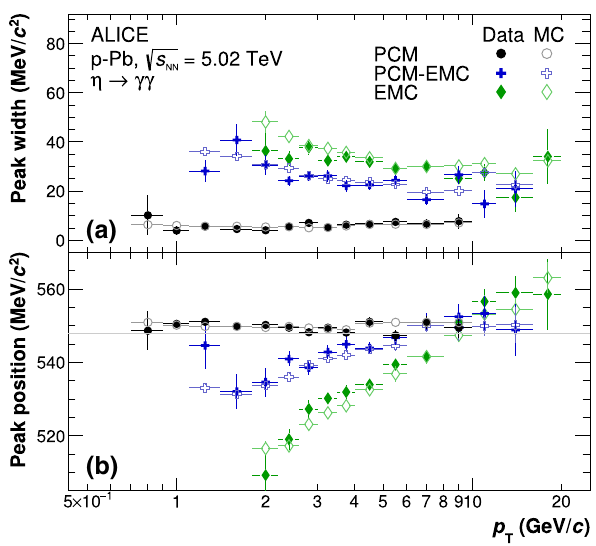
Fig. 3 Reconstructed π 0 masswidth(top)andposition(bottom)versus p T for data and Monte Carlo simulation for all five methods